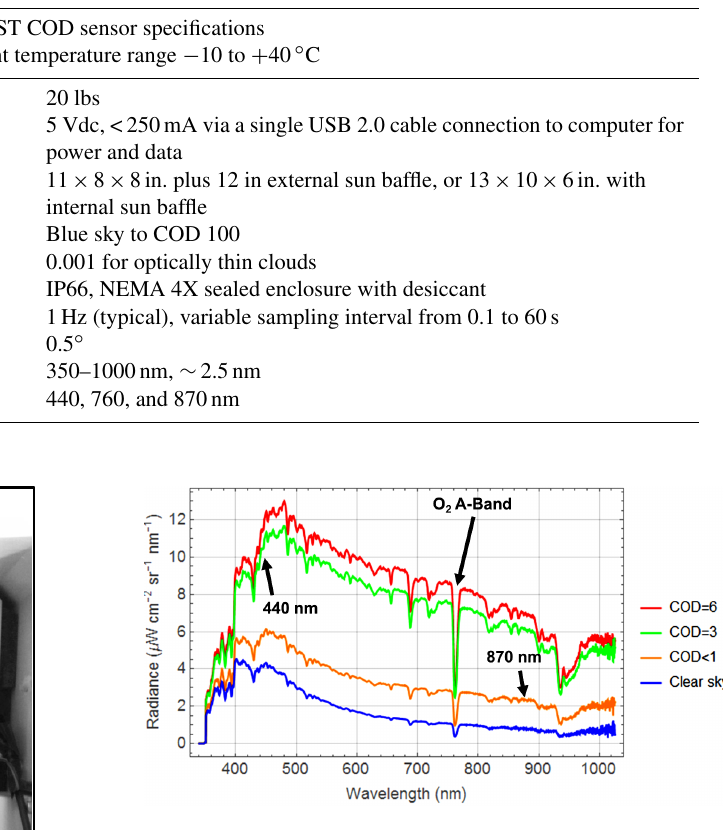
Figure 3. Example spectra measured by TWST sensor, delineating the three spectral factors currently used in TWST retrieval algo- rithm. Spectra measured at SZA = 65 ◦ within